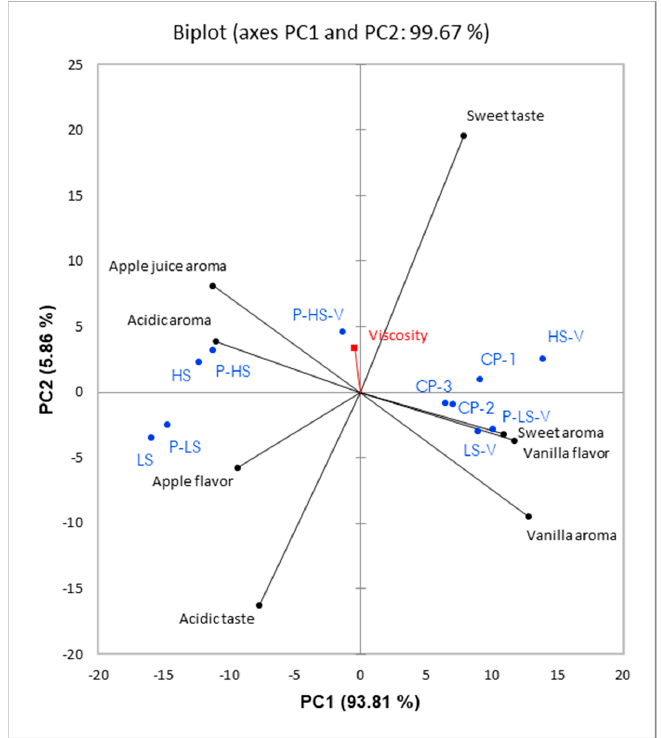
Figure 2. Principal Component Analysis (PCA) biplot of the results from the Descriptive Analysis (DA) of the apple nectar matrix. PC1 explains 93.81% of the variation and PC2 explains 5.86% of the variation in the data. Attributes are marked in black, samples are marked in blue, and the supplementary variable viscosity is marked in red. Samples are labelled according to Table 1.